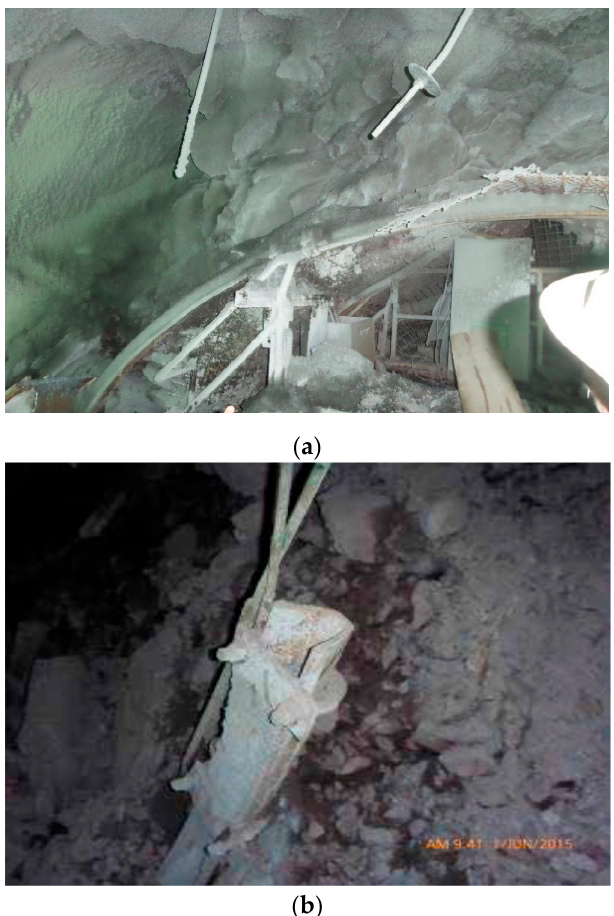
Figure 9. Dynamic failure of supports in Tunnel 696. ( a ) Rock bolt and wire-mesh fabric; ( b ) sheared-off TH beam.